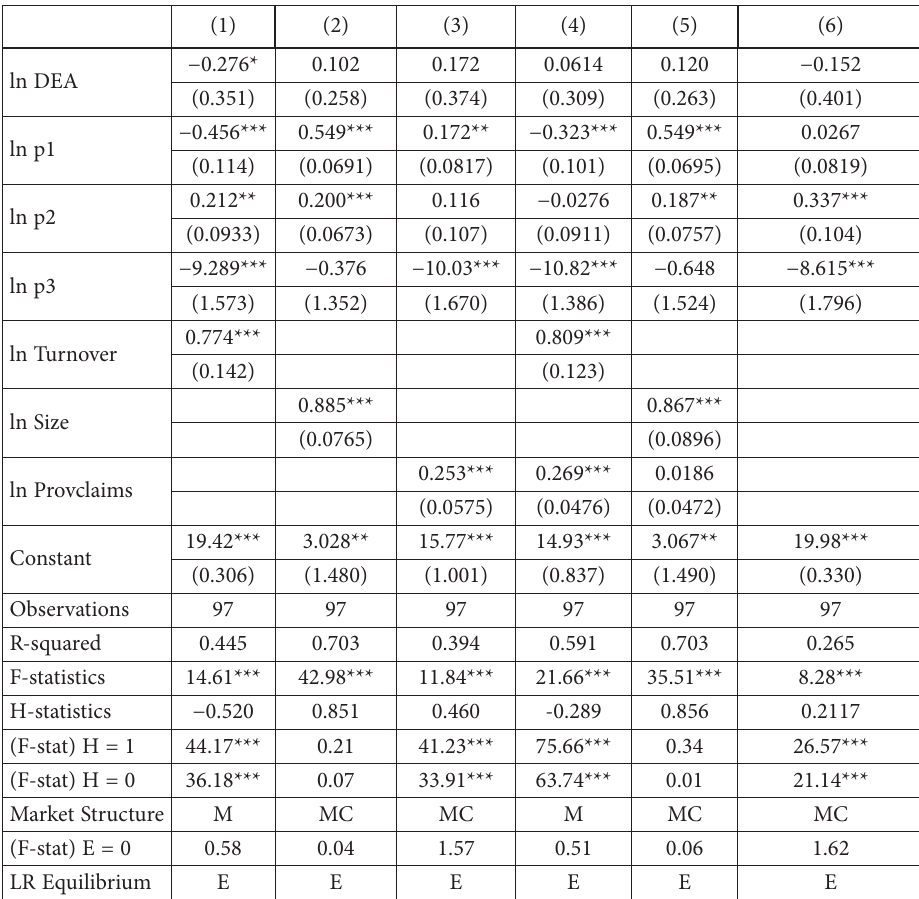
Table 6. Relationship between efficiency and